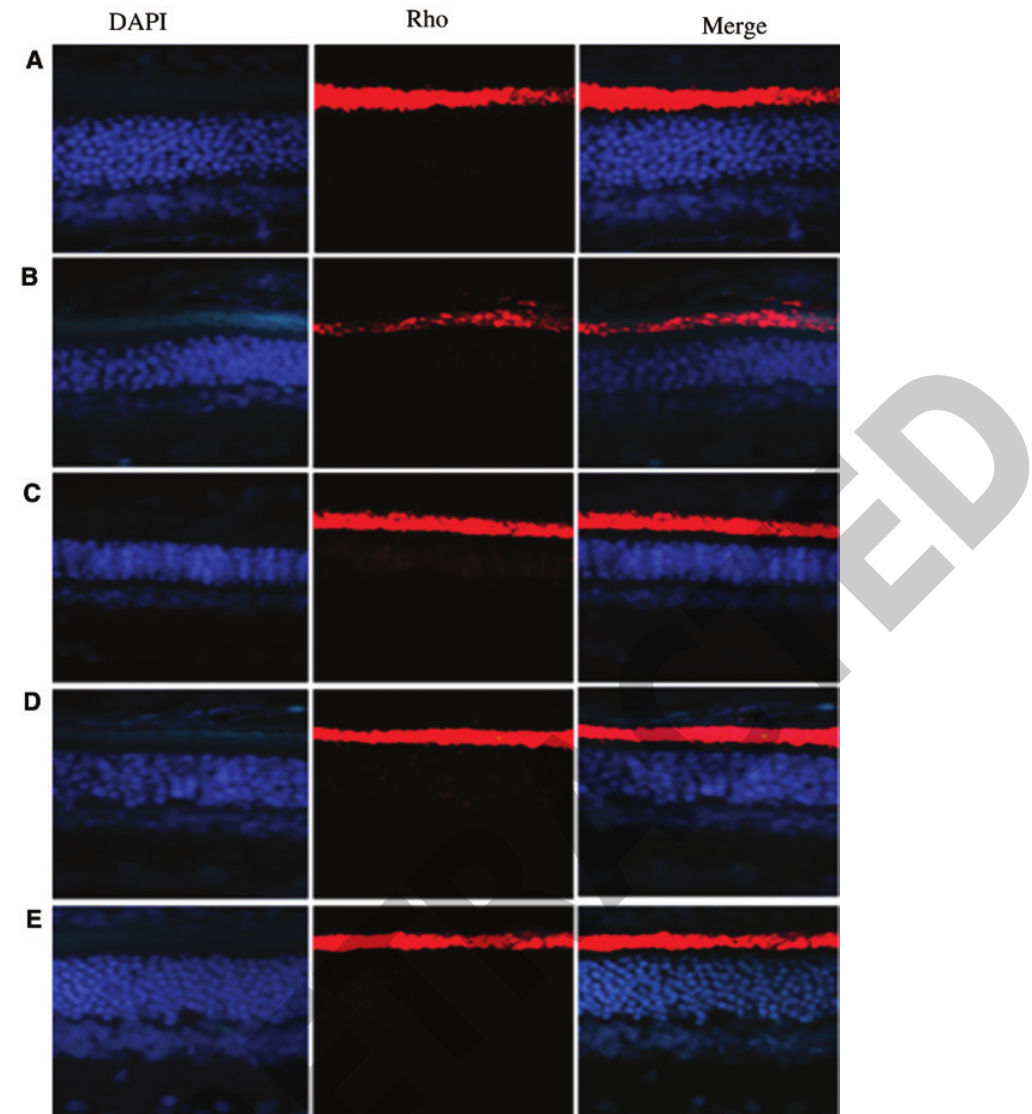
Figure 6: Immunohistochemical evaluation of the rod photoreceptor marker rhodopsin. Representative retinal sections of control- (A), ADan-red- (B), ADan-oxi- (C), A β 1-40- (D), and A β 1-42- (E) injected eyes that were labeled with rhodopsin (red). Nuclei are labeled with DAPI (blue). Scale bar: 50 μ m.